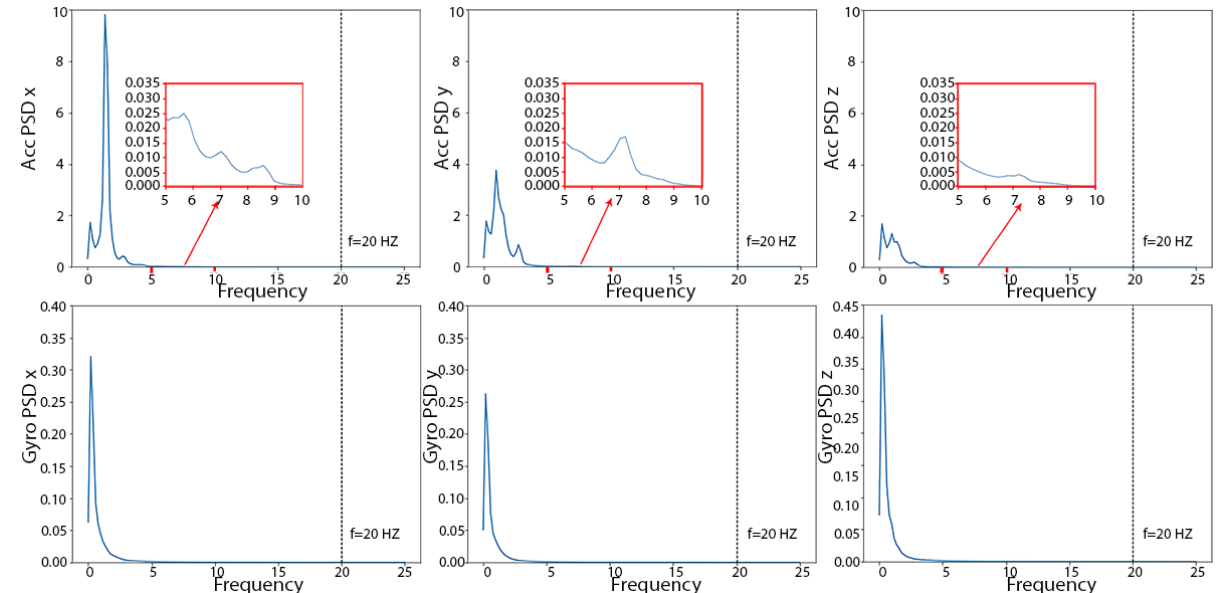
Figure 10. Triaxial (x, y, and z) power spectra density curves of accelerometer (upper 3 subplots) and gyroscope meter (lower 3 subplots) of the BREATHE training dataset. ACC: accelerometer; Gyro: gyroscope; PSD: power spectral